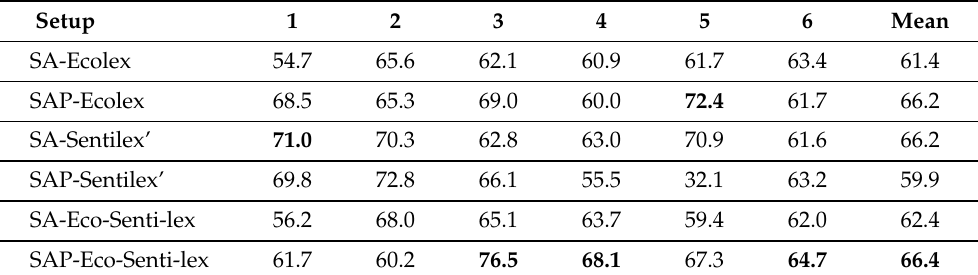
Table 11. Weighted F1-score results on long sentences. Setup